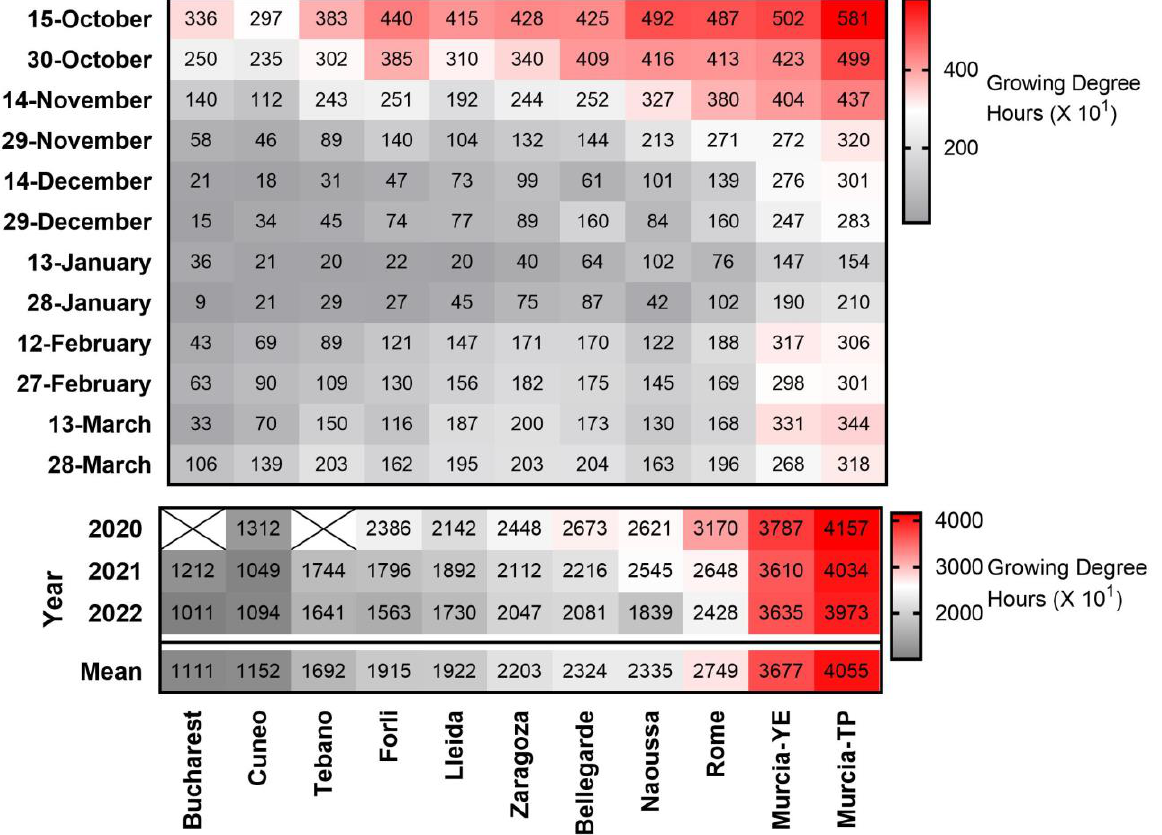
Figure 3. Heat-map presenting heat accumulation (in growing degree hours (GDH) (X10 1 )) accumu- lated during 15-day periods from 1 October until 29 March in 11 European sites in the 2019–2022 three-year period. The sum of GDH during February–March is also presented for each studied period and year. X = no data. YE = Yéchar; TP = Torre Pacheco.